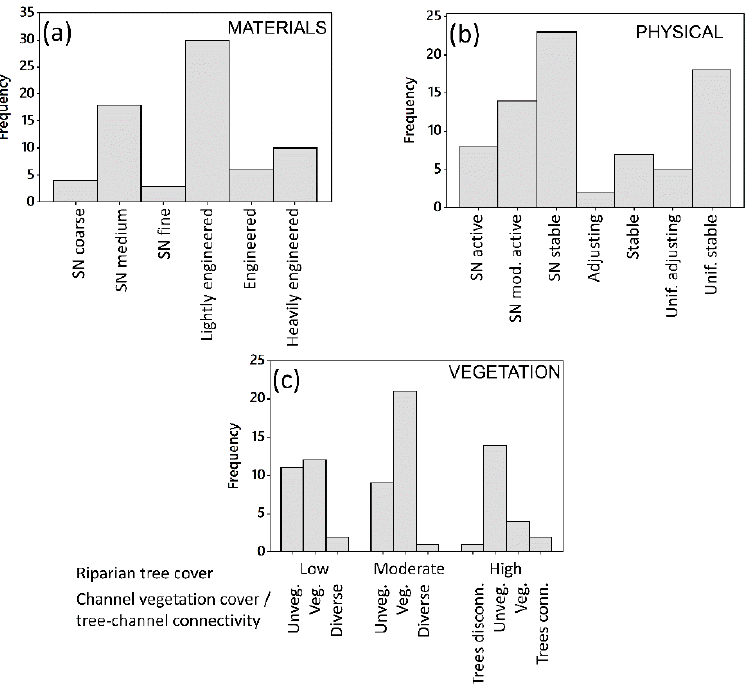
Figure 6. Frequency distributions of ( a ) Materials, ( b ) Physical Habitat, and ( c ) Vegetation classes from the PlaceMarker River Survey data (2014-18). Full definitions and descriptions of indices are provided in the Supplementary Information (2) PlaceMarker: Classifications and Indices . In particular, refer to Tables 1 (pp. 3–13), 4, 5, and 6 (pp. 21–23).